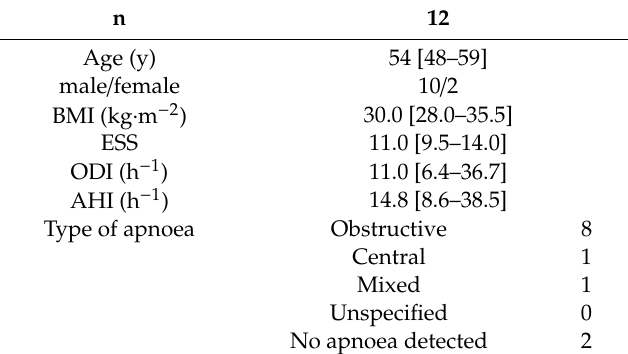
Table 1. Baseline characteristics of the study